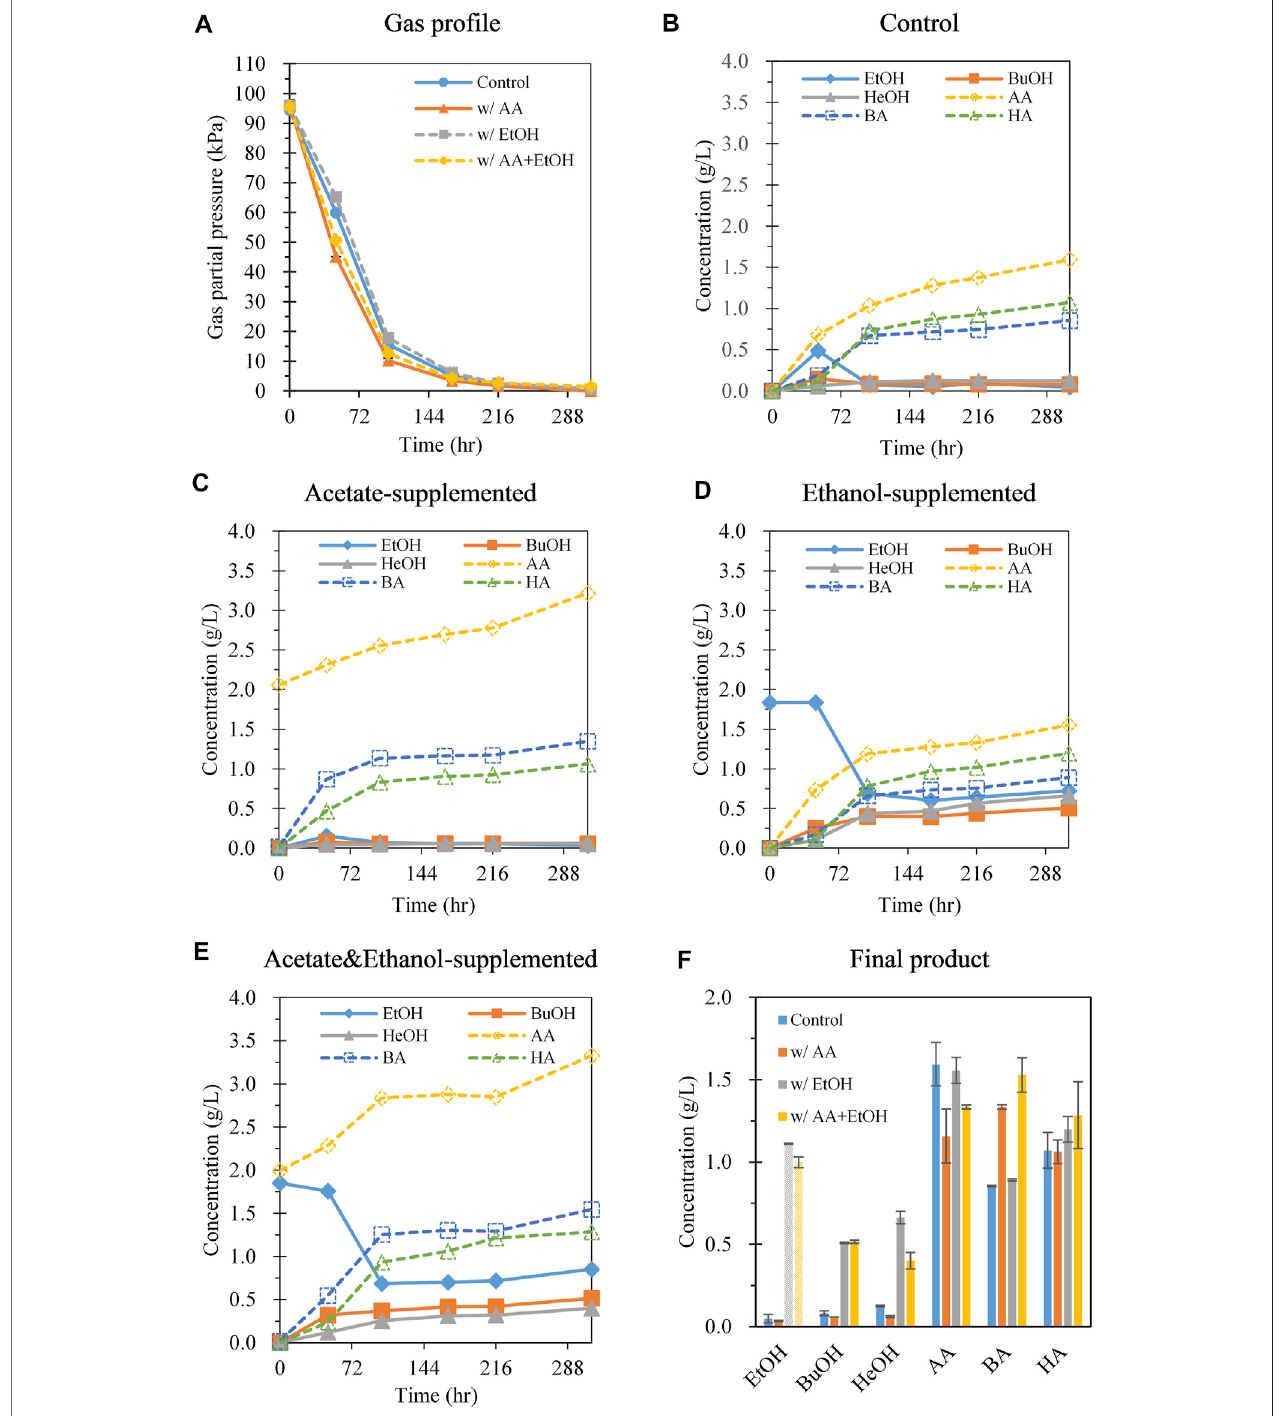
FIGURE 2 | Effect of adding C2 compounds (acetate, ethanol, and acetate + ethanol) on gas consumption and metabolite production during batch gas fermentation with 70% CO gas. (A) Gas pressure pro fi les; (B) control (no addition of acetate and ethanol); (C) addition of acetate (2 g/L); (D) addition of ethanol (2 g/L); (E) addition of acetate (2 g/L) and ethanol (2 g/L); (F) metabolite concentration at 312 h. Shade pattern represents ethanol consumption. Each data point and error bar represent the average and range of duplicate experiments, respectively. EtOH, ethanol; BuOH, butanol; HeOH, hexanol; AA, acetic acid; BA, butyric acid; HA, hexanoic